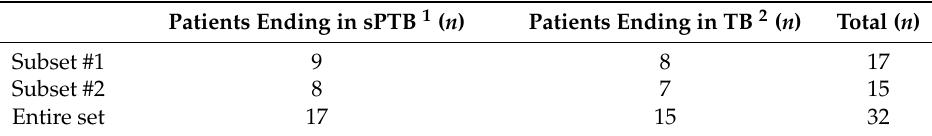
Table 3. Samples used for gene expression stability analysis.